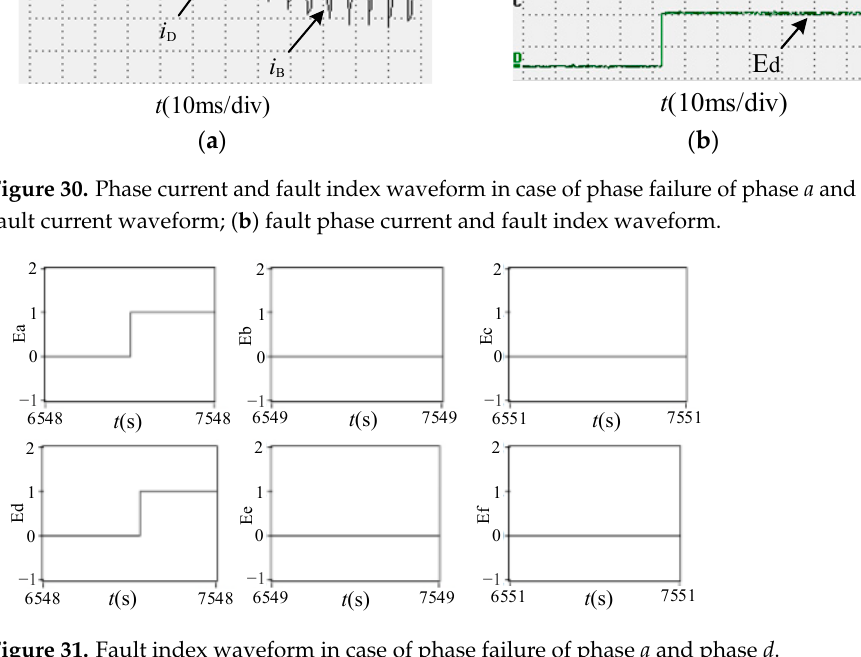
Figure 31. Fault index waveform in case of phase failure of phase a and phase d .